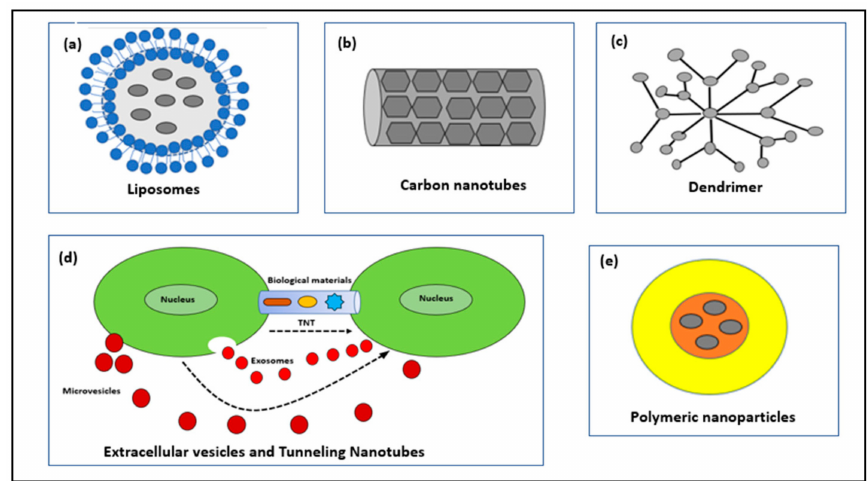
Figure 2. Schematic illustration of nanocarriers for the delivery of